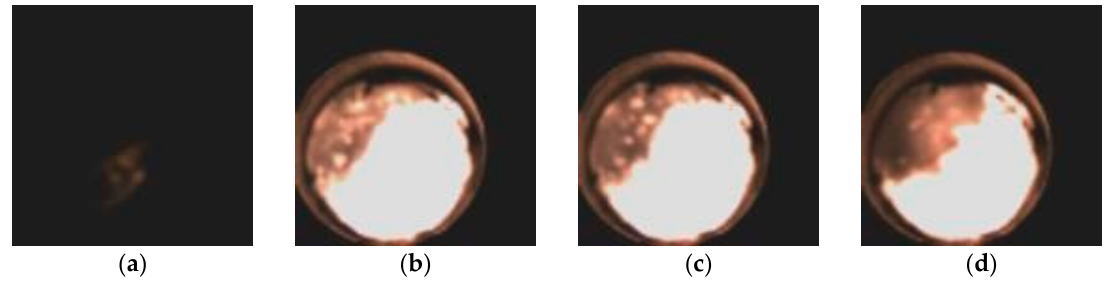
Figure 2. Flame image of series 1. ( a ) Ignition moment; ( b ) maximum pressure rise rate; ( c ) maximum heat release; ( d ) the highest pressure.